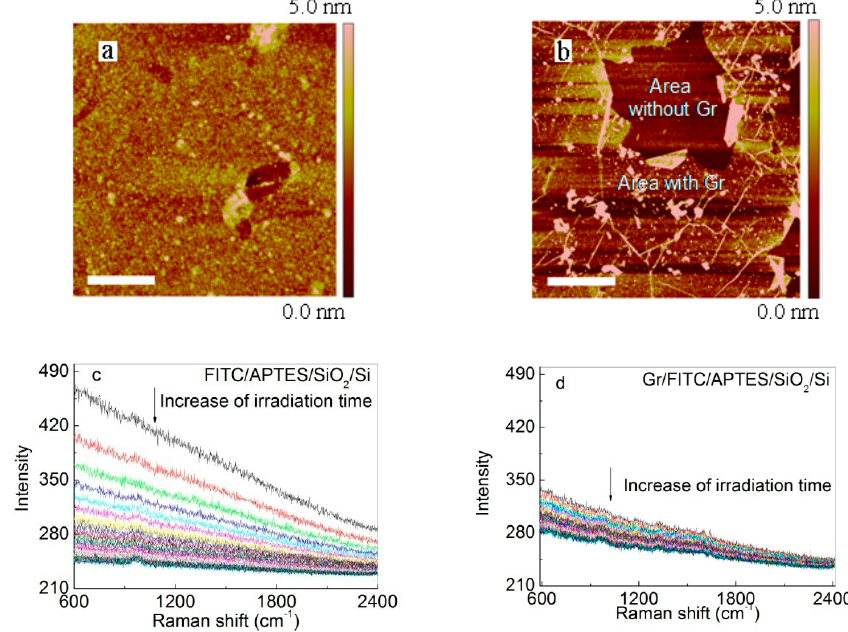
Figure 2. Typical (top) atomic force microscopy (AFM) images and (bottom) Raman-fluorescence spectra of FITC in the absence/presence of graphene (Gr): ( a ) FITC/APTES/SiO 2 /Si, washed in acetone for 27 h; ( b ) Gr/FITC/APTES/SiO 2 /Si, washed in acetone for 12 h. The time evolution of the fluorescence spectra ( c , d ) is used to quantify the photo-bleaching kinetics of the dye. The spectrum was integrated for 5 s, with continuous laser exposure and 5 s delay between spectrum acquisitions. Scale bars in the AFM images represent 500 nm in ( a ) and 1 μ m in ( b ).